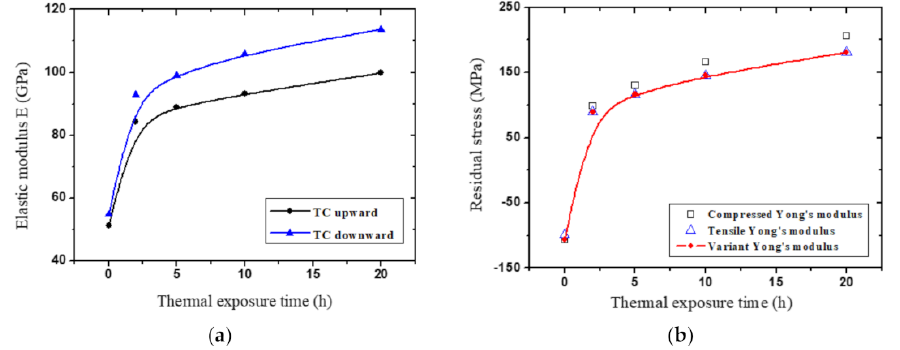
Figure 12. Relation curves of ( a ) elastic modulus; and ( b ) residual stress with high temperature exposure